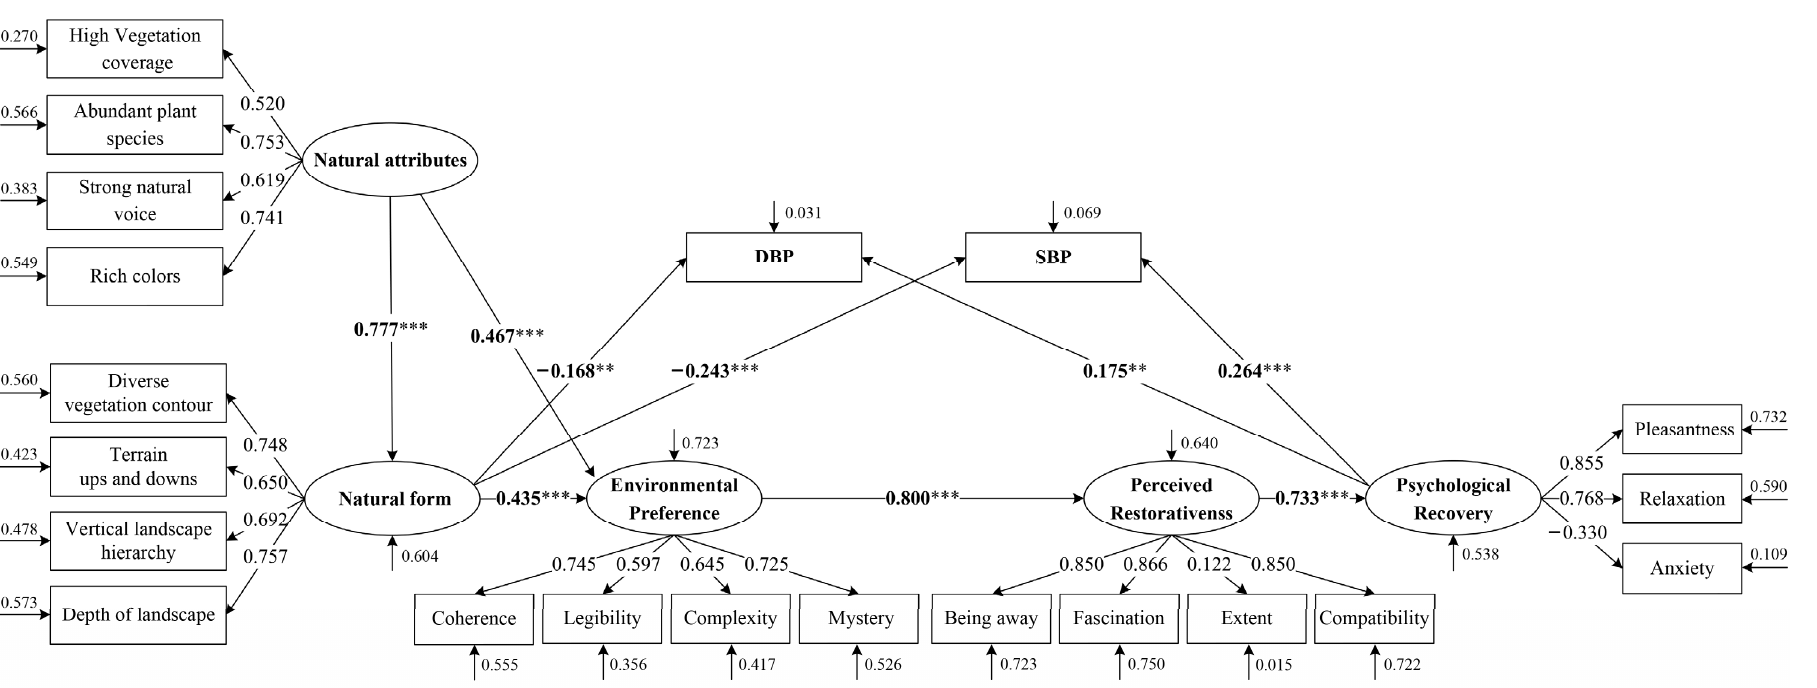
Figure 6. The final associations among the study variables. Fit indexes: Chi-square/df = 1.18, GFI = 0.97, AGFI = 0.96, RMSEA = 0.02, IFI = 0.99, NFI = 0.97, CFI = 0.99, TLI = 0.99, RFI = 0.97. The model fits well. ** p < 0.01; *** p < 0.001. SBP: systolic blood pressure; DBP: diastolic blood pressure. This figure was created by Rui Chen.